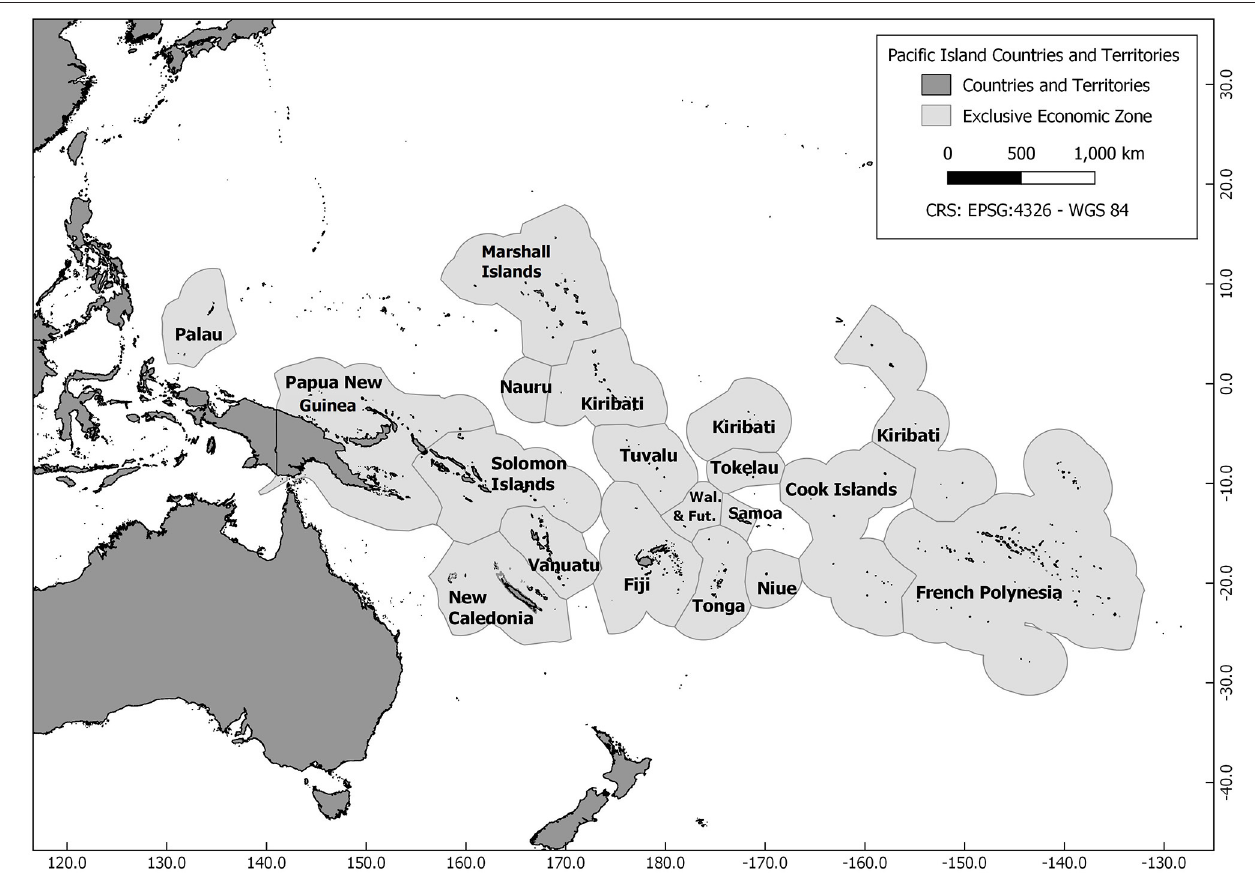
FIGURE 1 | Pacific Islands cited in this study and their maritime boundaries. Wal.&Fut. on the map represents Wallis and Futuna. Source: Flanders Marine Institute (2019)